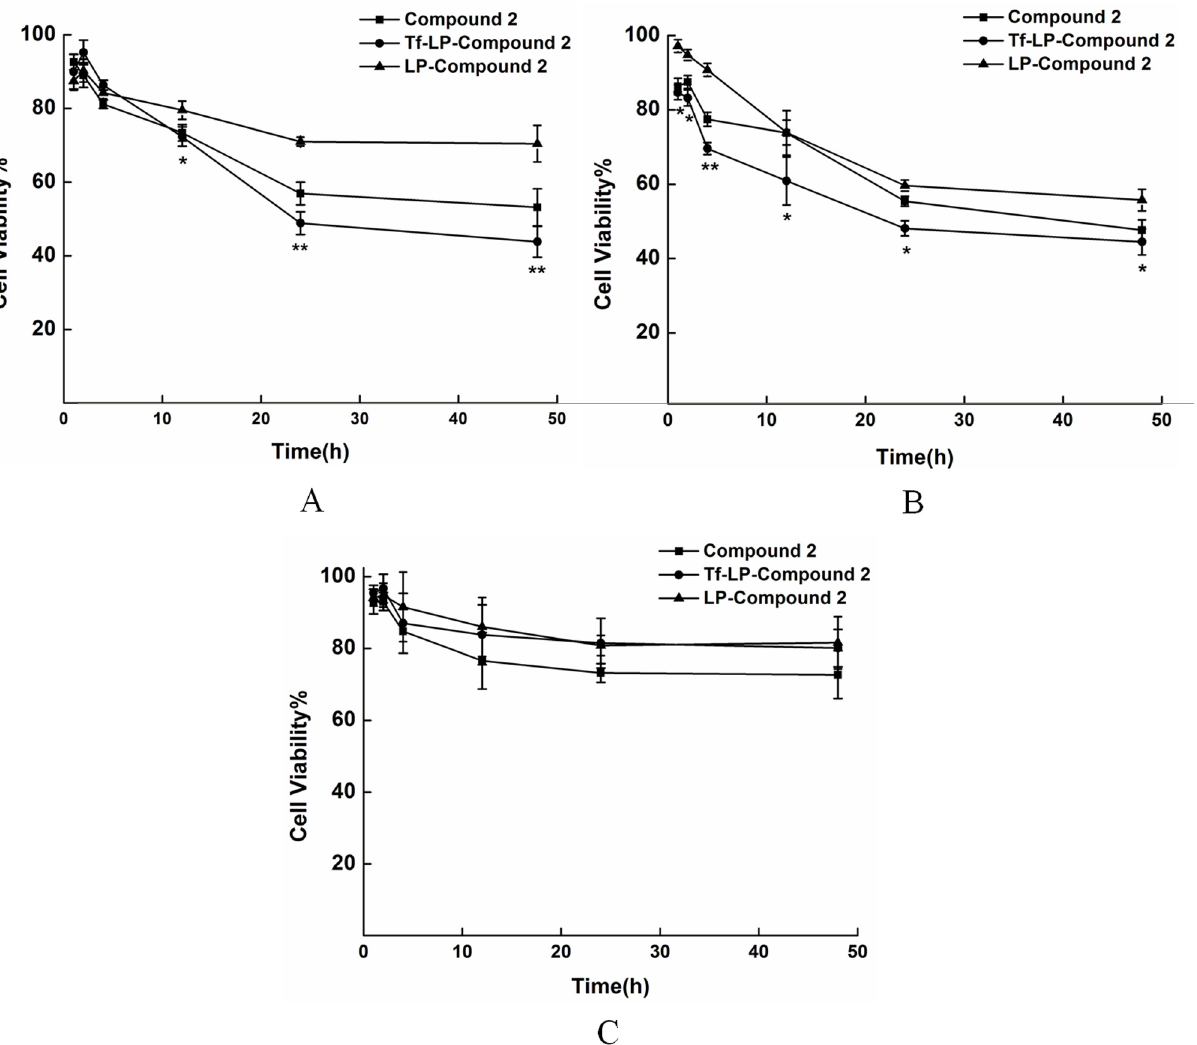
Fig 4. In vitro release of LP-Compound 2, Tf-LP-Compound 2 and free Compound 2. Drug release during 24 h incubation in PBS (0.5%v/v Tween 80) at 37 degree C, mean SD values (n = 3) are presented.